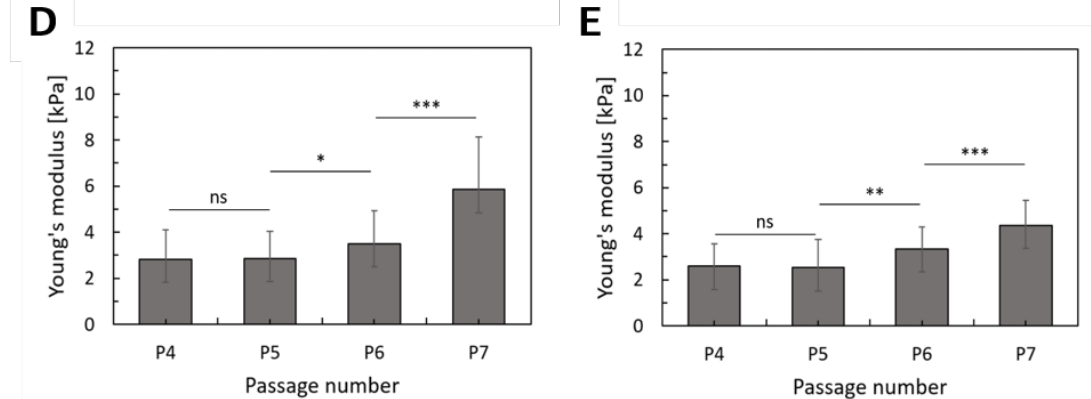
Figure 4. ( A , B ): The donor’s influence on the elasticity of WJ-MSCs from P4 to P7. Each donor is represented in the figures by a color. The results for each donor are presented as a mean determined for 60 cells. Young’s modulus calculated for indentation depths 300 nm ( A ) and 500 nm ( B ). ( C ): Intra-class correlations (ICC) obtained for all Young’s modulus determined for all participating donors. The values close to 0 indicate no compliance, while values close to 1 show perfect compatibility. ( D , E ): The elasticity of cells measured at various passage number (from P4 to P7), an average of 10 donors. The Young’s modulus is presented as a mean ± standard deviation determined for 600 cells from 21 600 sampling points. Young’s modulus calculated for indentation depths 300 nm ( D ) and 500 nm ( E ). An ANOVA test was applied to statistically verify the obtained results (ns: no significant di ff